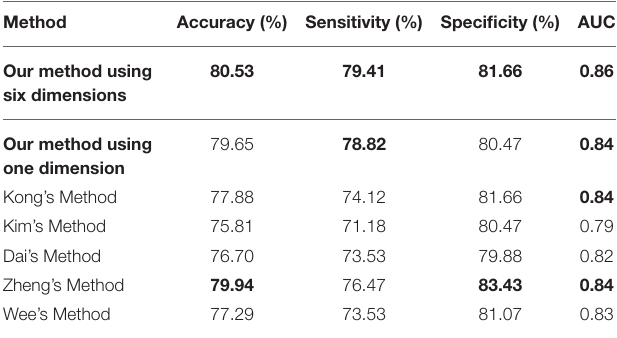
TABLE 4 | Classification performance of different methods to distinguish MCI and NC.